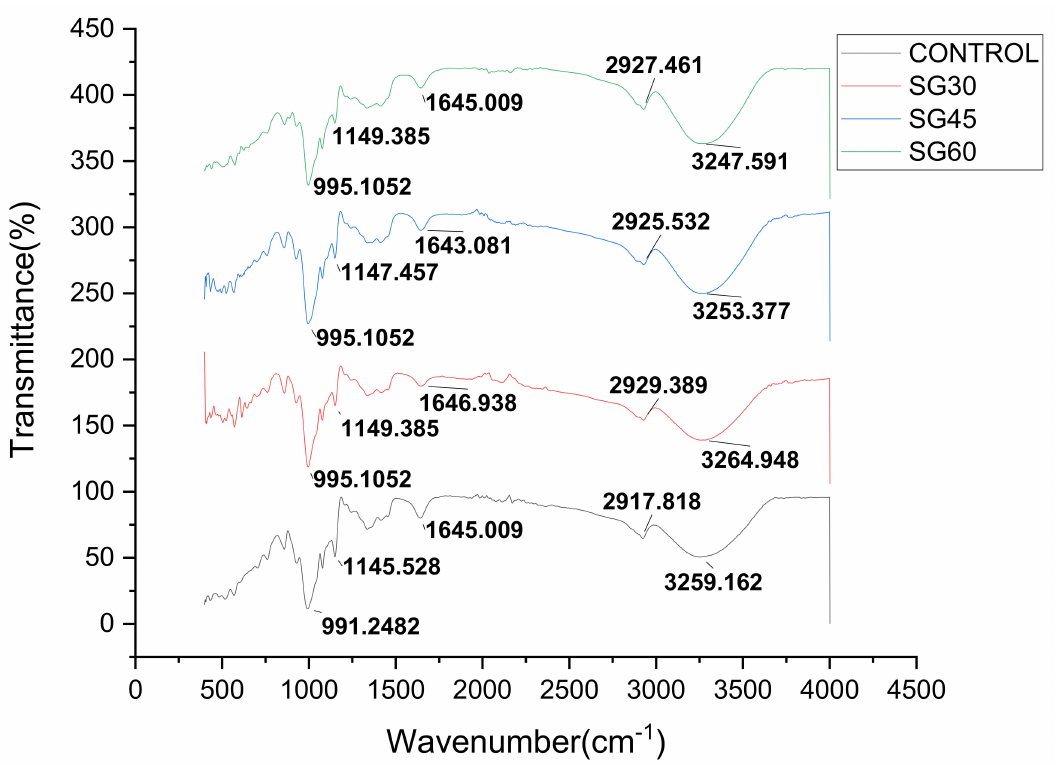
Figure 9. FTIR curves of CS films with various sorbitol/glycerol